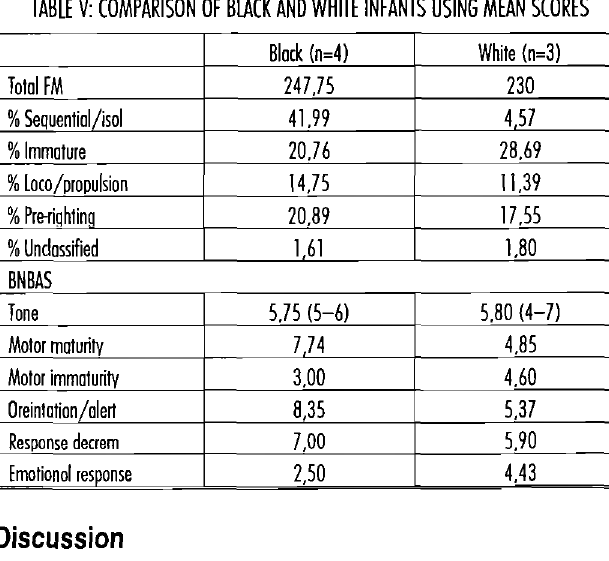
TABLE V: COMPARISON OF BUCK AND WHITE INFANTS USING MEAN